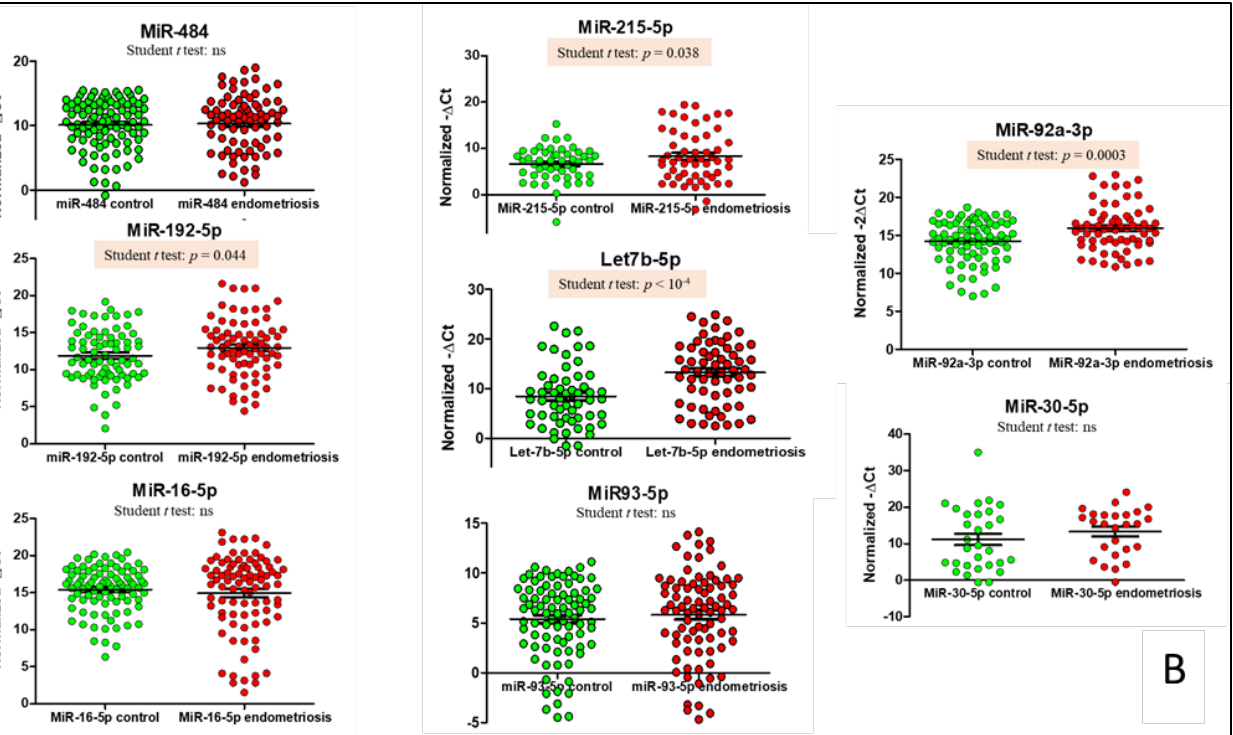
Figure 1. ( A ) Differentially expressed miRNAs in ovarian endometrioma, the eutopic endometrium and normal endometrium. OMA: endometrioma; EE: eutopic endometrium. n = 4 patients with endometrioma (providing OMA and matched EE). n = 7 controls (providing normal endometrium). Expression was based on qPCR quantification. p -values are based on ANOVA and Fisher test, followed by a Student t -test for comparing Ectopic Endometrium (EE) versus ovarian endometriotic lesion (OMA) from the same patient. ( B ) Differentially expressed miRNAs in the plasma of patients with ovarian endometrioma (red) and controls (green). N = 93 patients with endometrioma (endo). N = 95 controls (only part of them were detectable for miR-30-5p). Expression was based on qPCR quantification. p -values are based on Student’s t test.